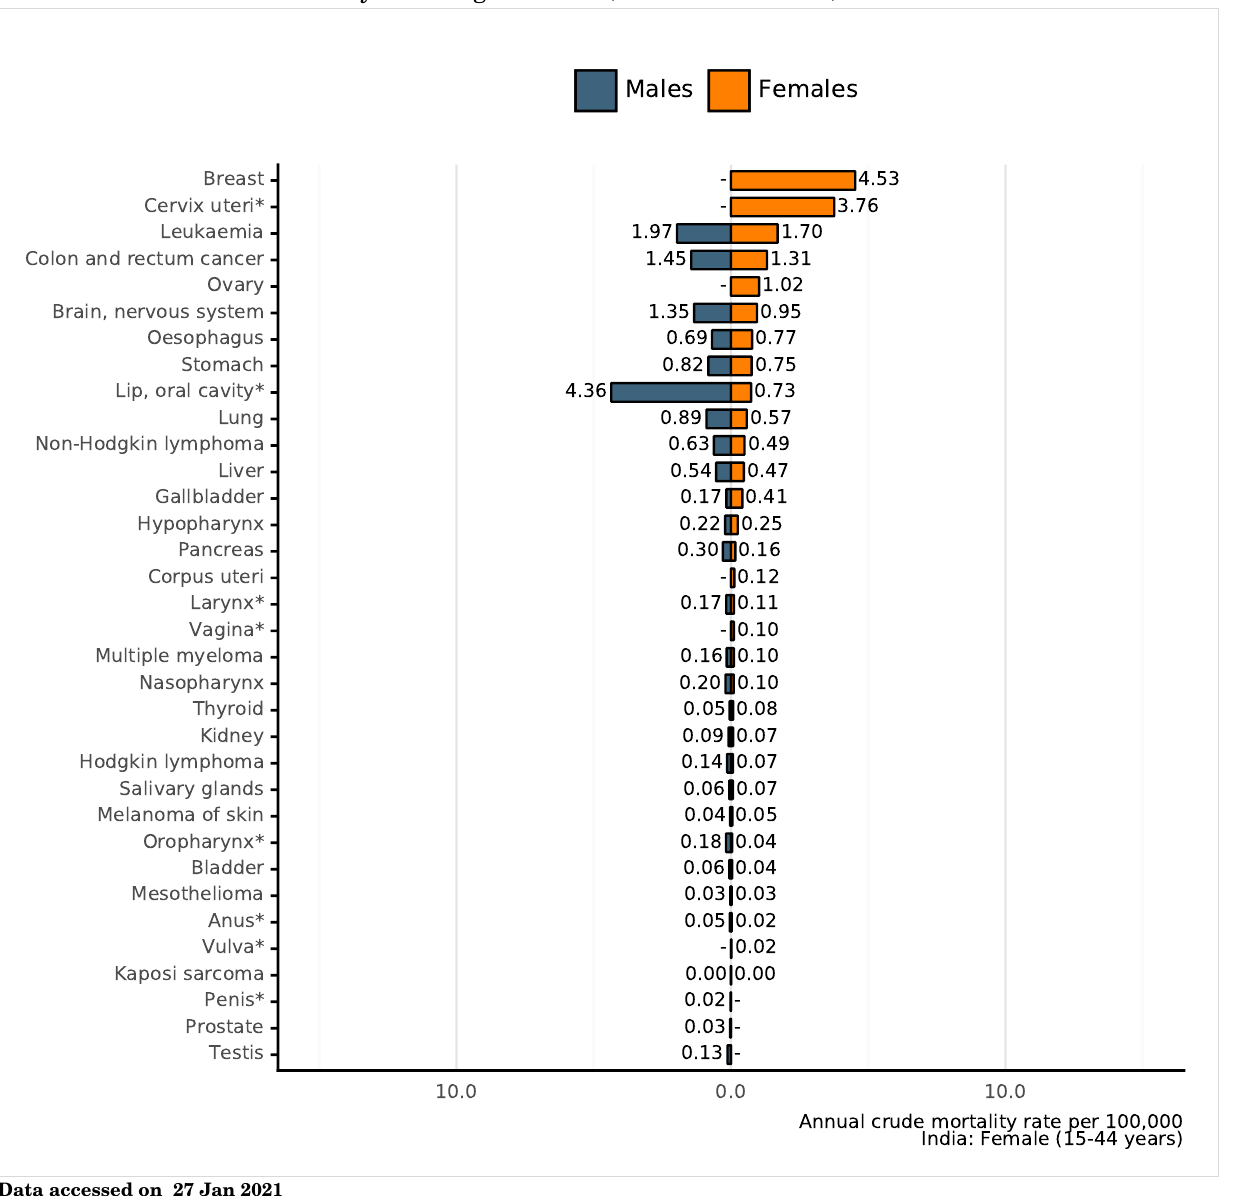
Figure 7: Comparison of HPV related cancers mortality to other cancers among men and women 15-44 years of age in India (estimates for